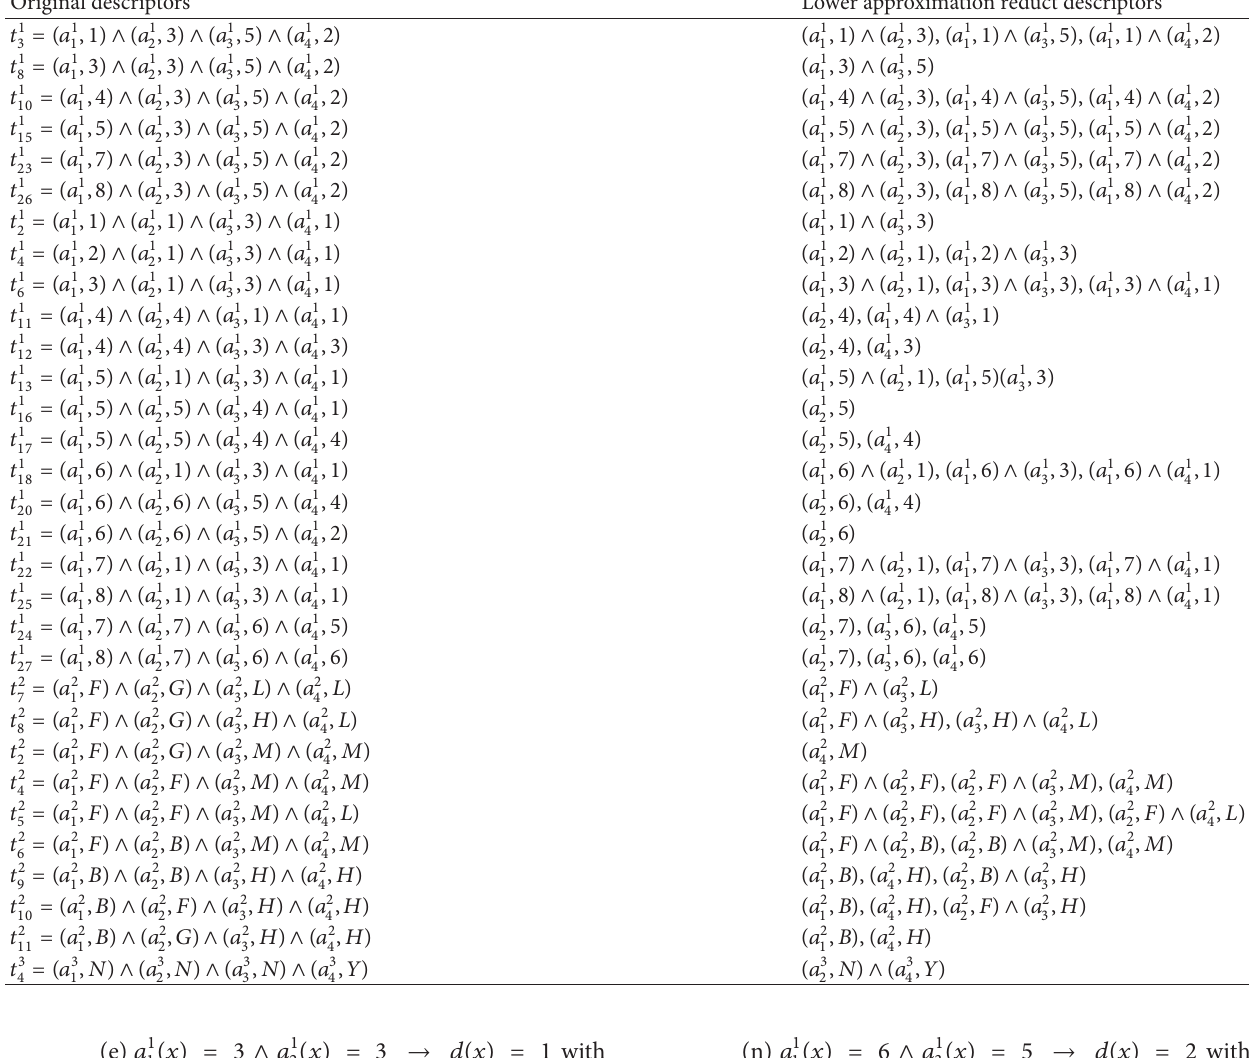
Table 5: Lower approximation reduct